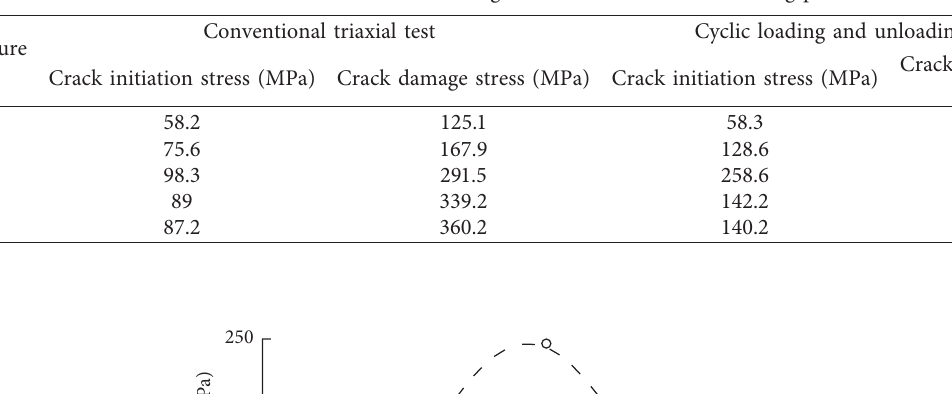
Figure 6: Determination of crack initiation stress and crack damage stress. Table 7: Crack initiation stress and crack damage stress under various confining pressures.